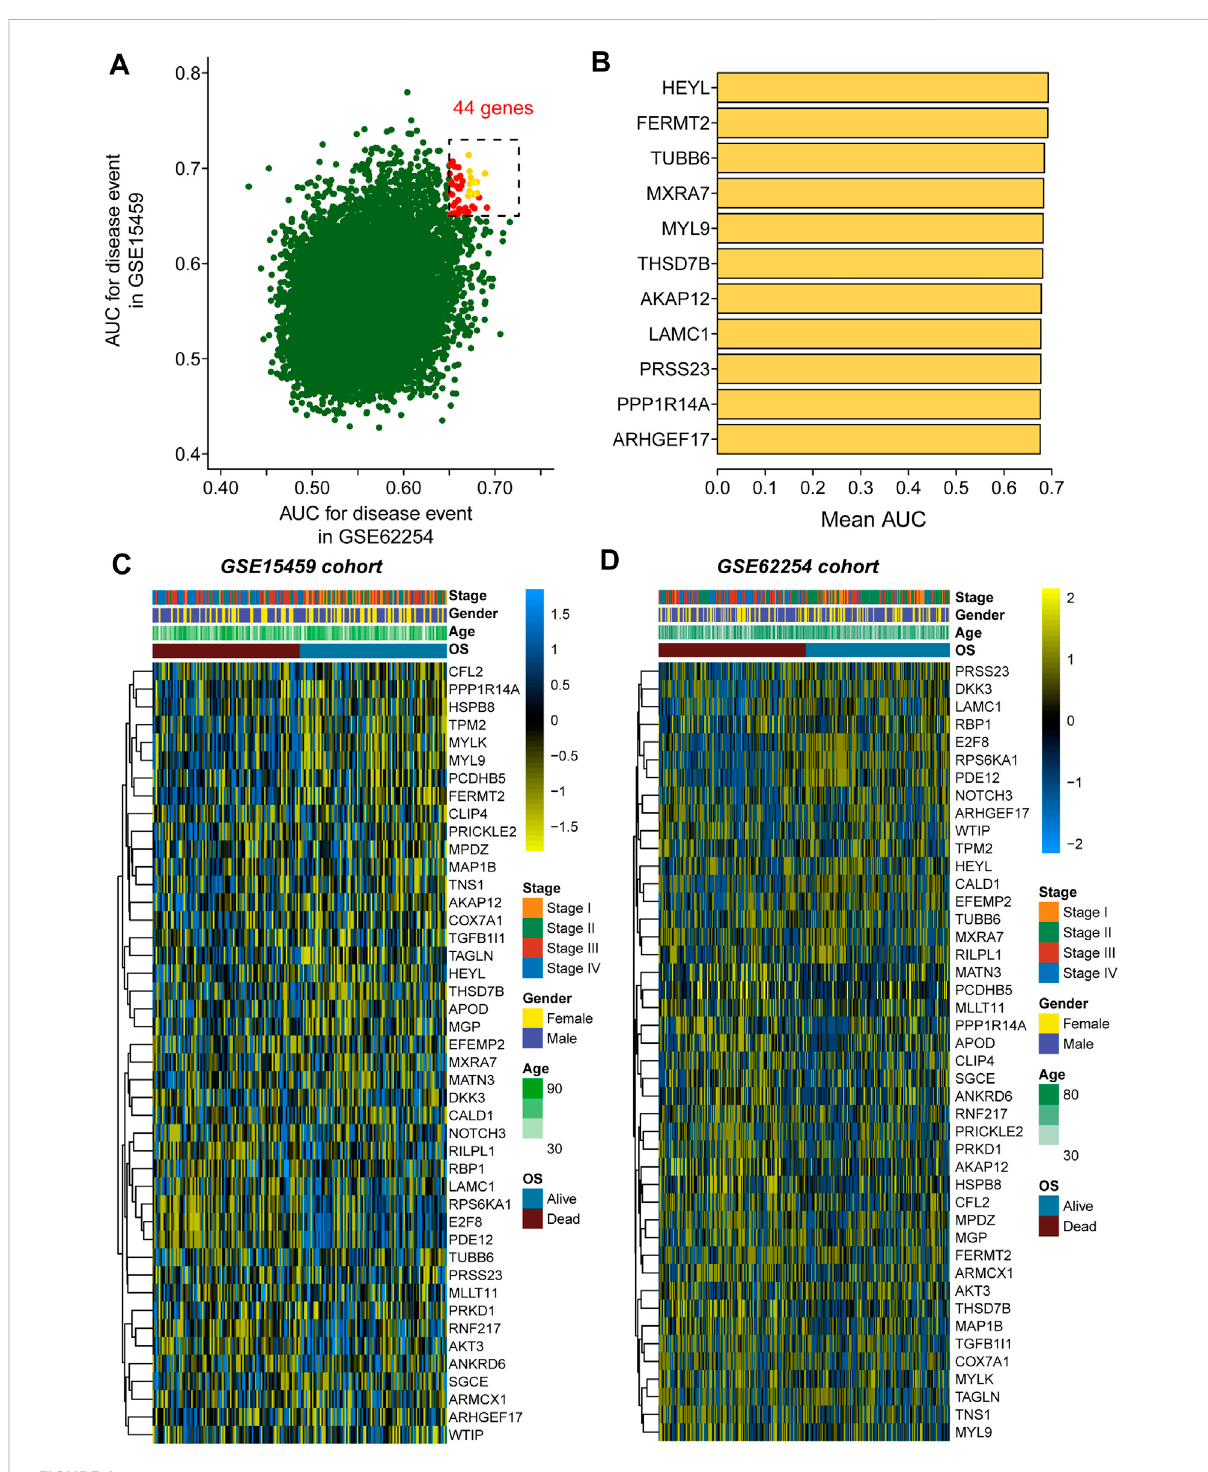
FIGURE 1 Selection of the 44 prognostic genes in GC patients. (A) , Scatter plot showing the prognostic value of genes in both the GSE62254 and GSE15459 cohorts; (B) , Eleven genes with the top average AUC values; (C) , Heatmap showing the expression of 44 selected genes in the GSE15459 cohort; (D) , Heatmap showing the expression of 44 selected genes in the GSE62254